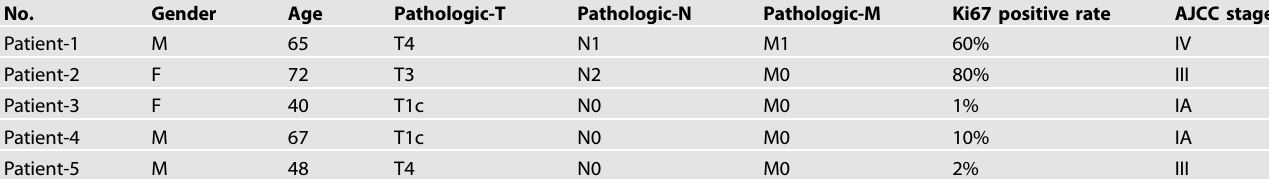
Table 1. The clinicopathological features of pancreatic cancer patients.